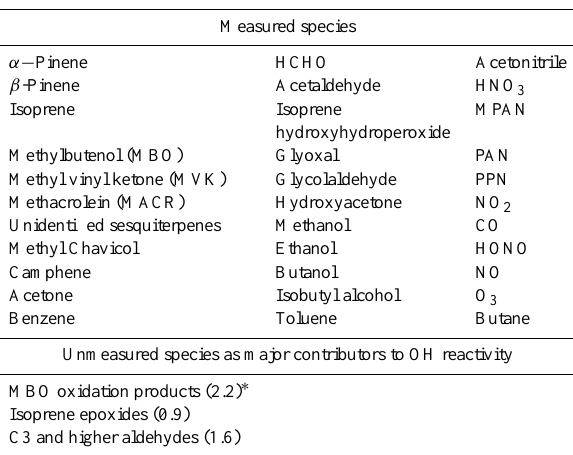
Table 1. VOCs and other chemical species measured and used in the OH reactivity calculation. Also listed are the unmeasured but modeled species that could be major contributors to OH